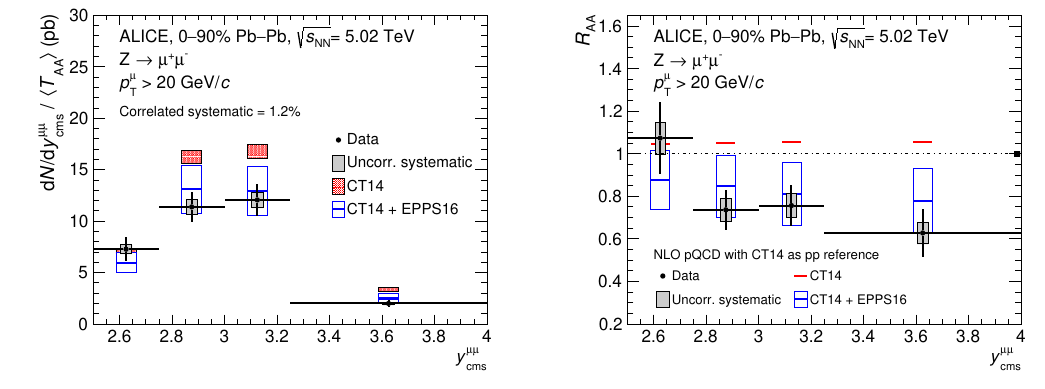
Figure 4 . Normalized invariant yield of Z ! (cid:22) + (cid:22) (cid:0) (left panel) and corresponding R AA (right p panel) as a function of rapidity, measured in 0{90% Pb-Pb collisions at s NN = 5 : 02 TeV. The vertical bars represent statistical uncertainties only. The horizontal extension corresponds to the rapidity bin width. The uncorrelated systematic uncertainties are reported as (cid:12)lled boxes. The R AA correlated systematic uncertainty is displayed as a box on the unity line in the right panel. The CT14 [50] (at NLO) pQCD proton-proton cross section is used as reference to compute R AA . The results are compared with free-nucleon PDF (CT14) and with nuclear PDF (CT14+EPPS16